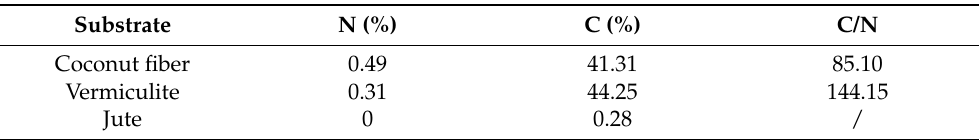
Values are means (n =